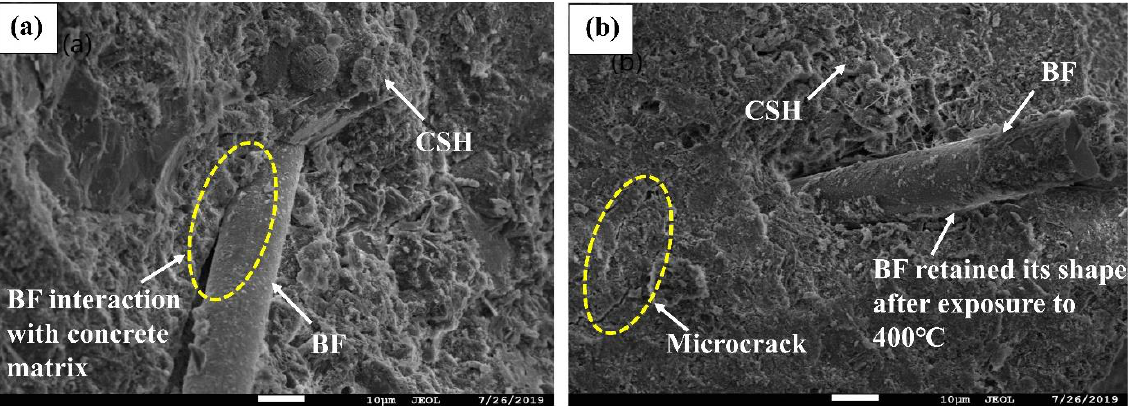
Figure 19. Microstructure of FRAC demonstrating the BF interaction with the host FRAC matrix at temperature exposure of ( a ) 200 ◦ C and ( b ) 400 ◦ C. Copyright permission is obtained from